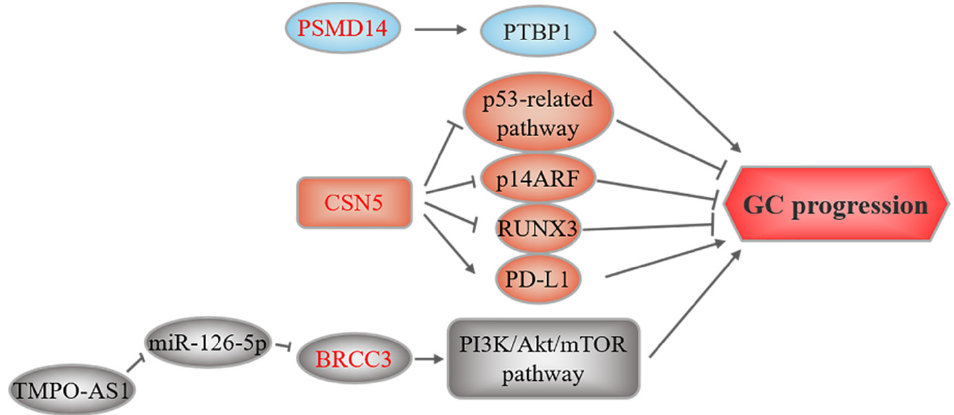
Figure 5. JAMM-related upstream regulation and downstream mechanisms in GC. These three members of JAMMs all play an oncogenic role. The text to the left and right of the JAMMs corresponds to the upstream regulatory events and downstream substrates, respectively.